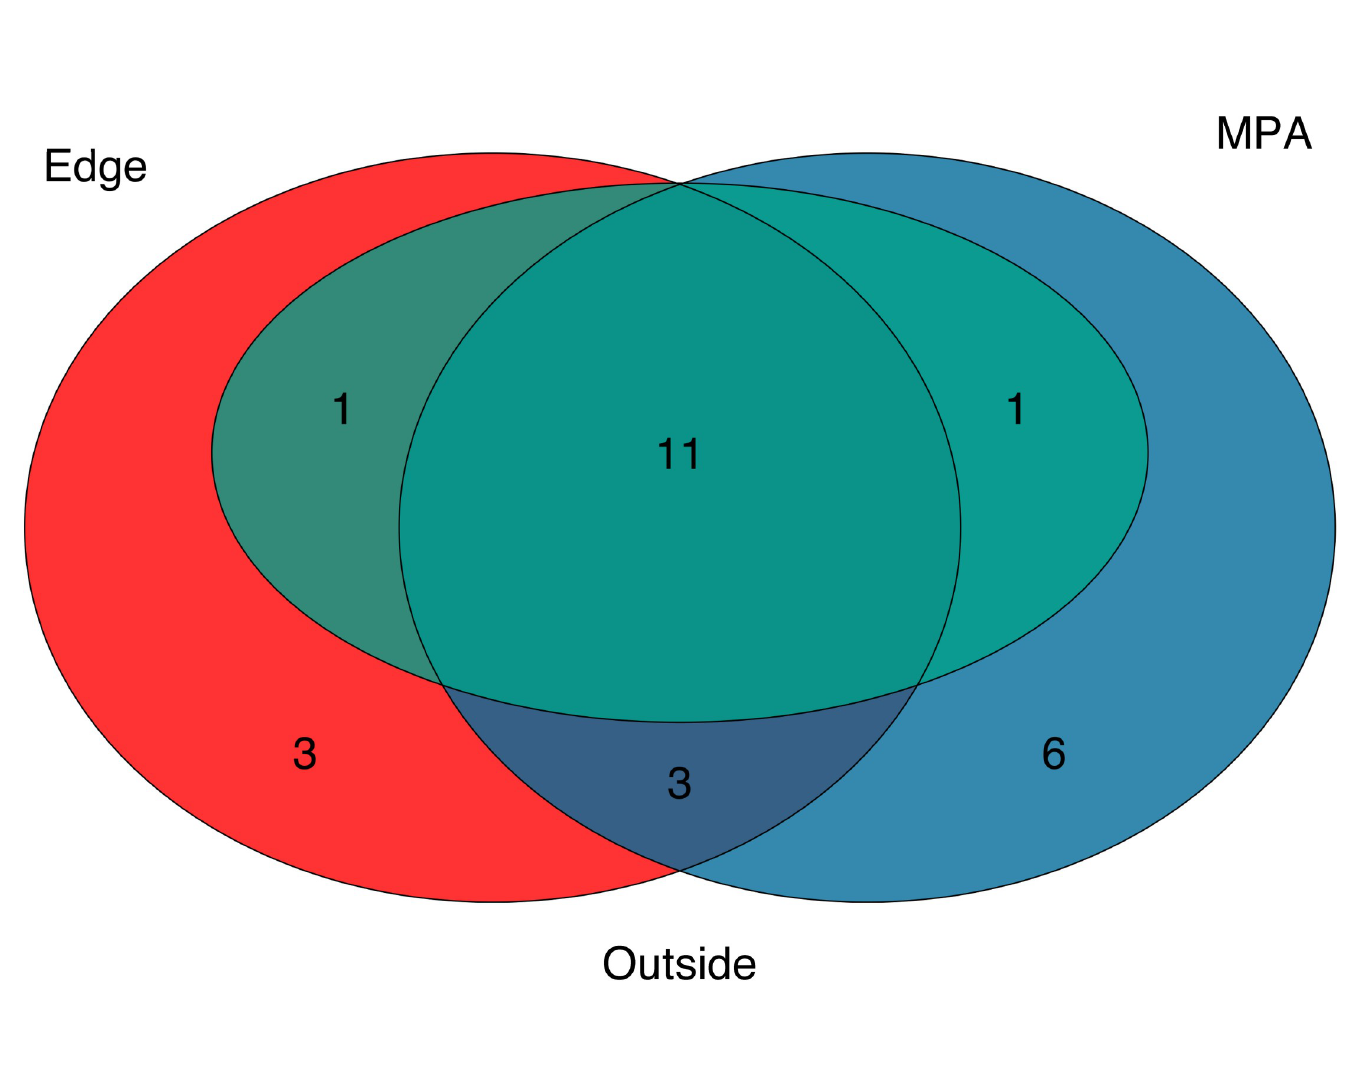
Fig 6. Venn diagram of species observed from visual SCUBA